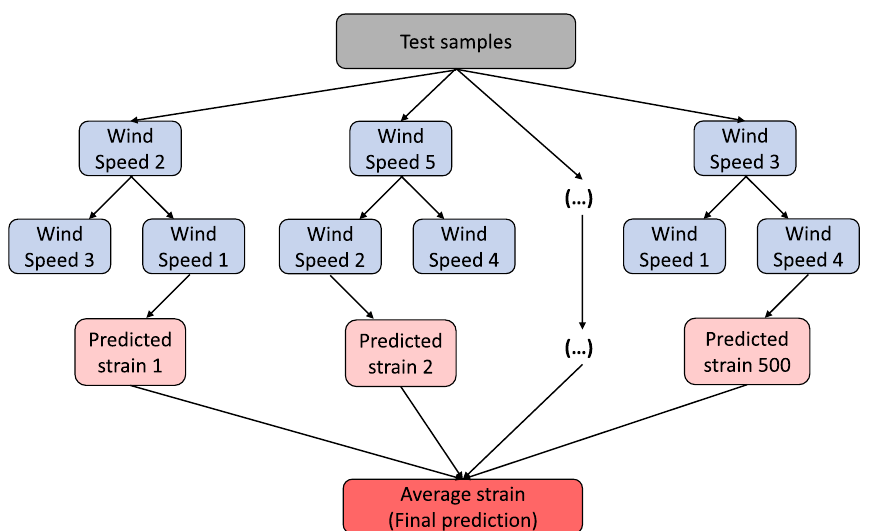
Fig. 4 Procedural implementation of random